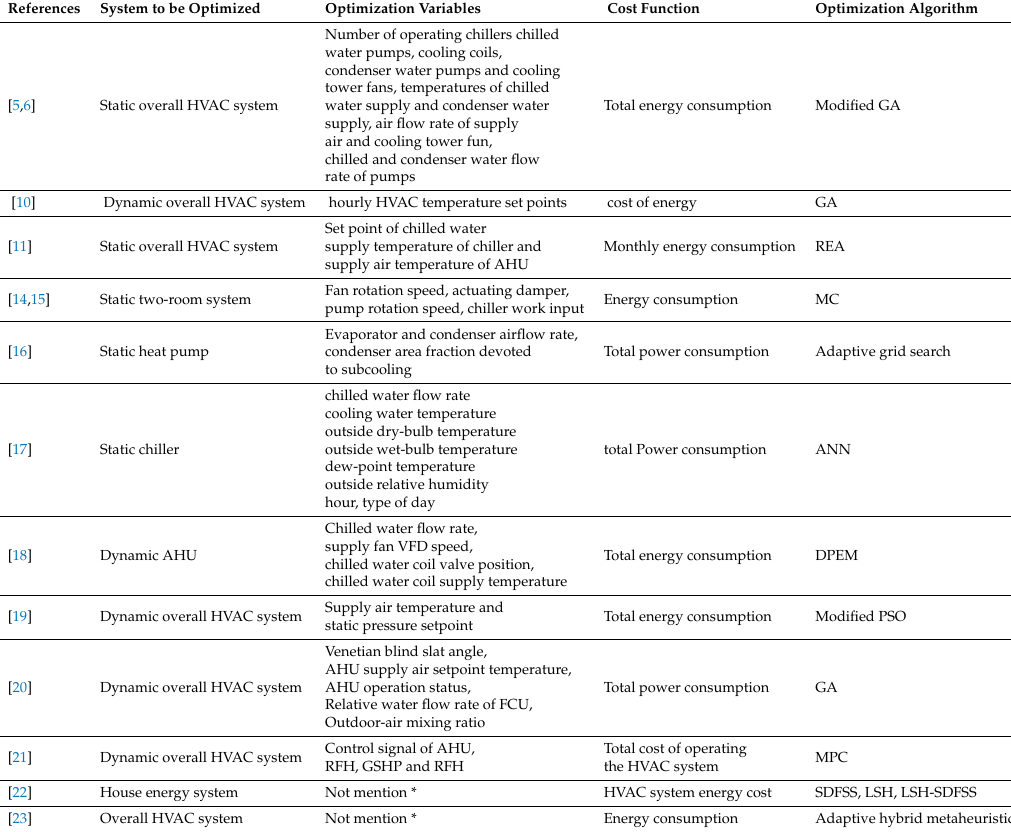
Table 1. Summary of the methods of modeling the heating, ventilation and air conditioning (HVAC)